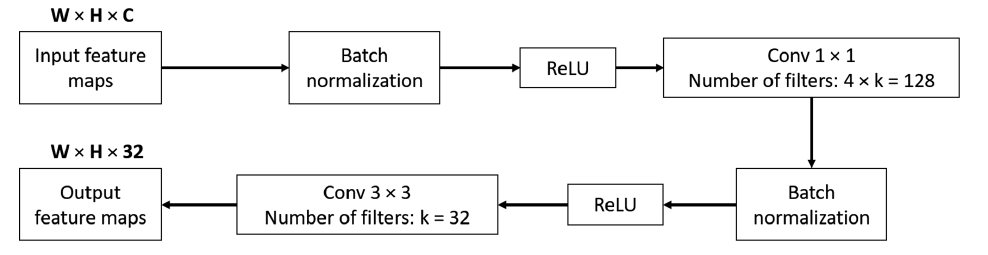
Figure 2. Bottleneck layer design.